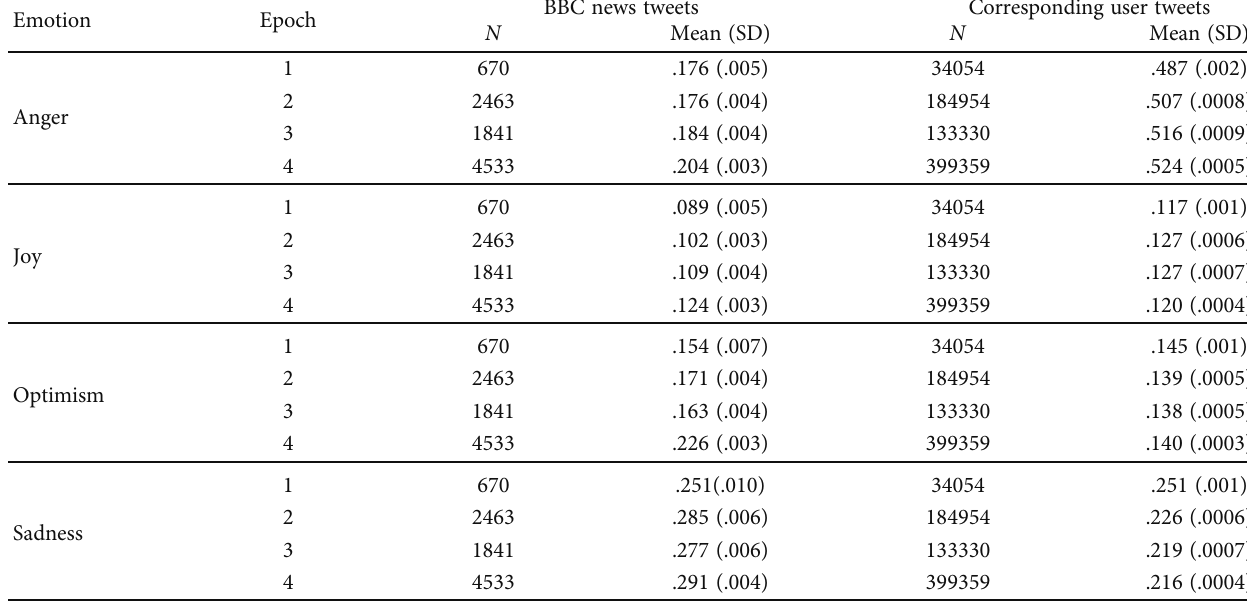
Table 8: BBC news (UK) tweet and user tweet dataset descriptives, by epoch.